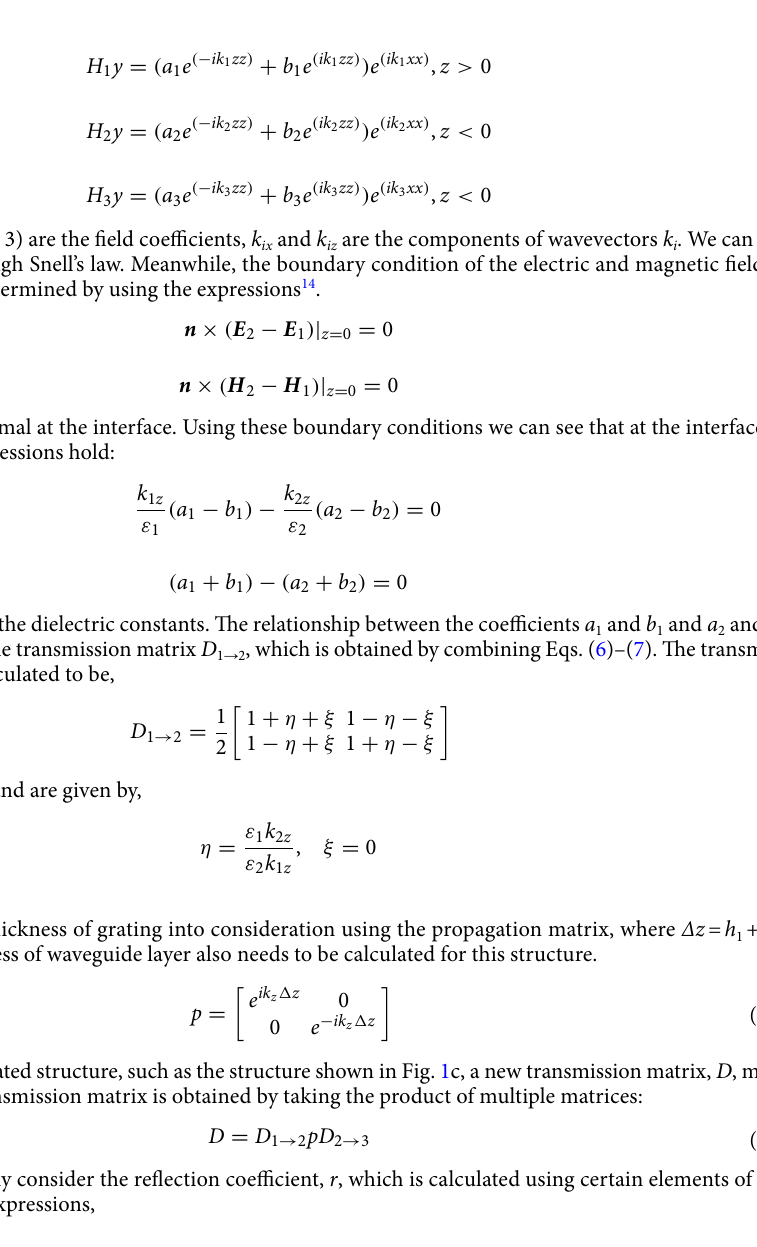
Figure 2. Schematic of the grating and the method used to calculate the wave propagation via the transmission matrix method. The grating is divided into three parts with dielectric constants ε 1 , ε 2 , and ε 3